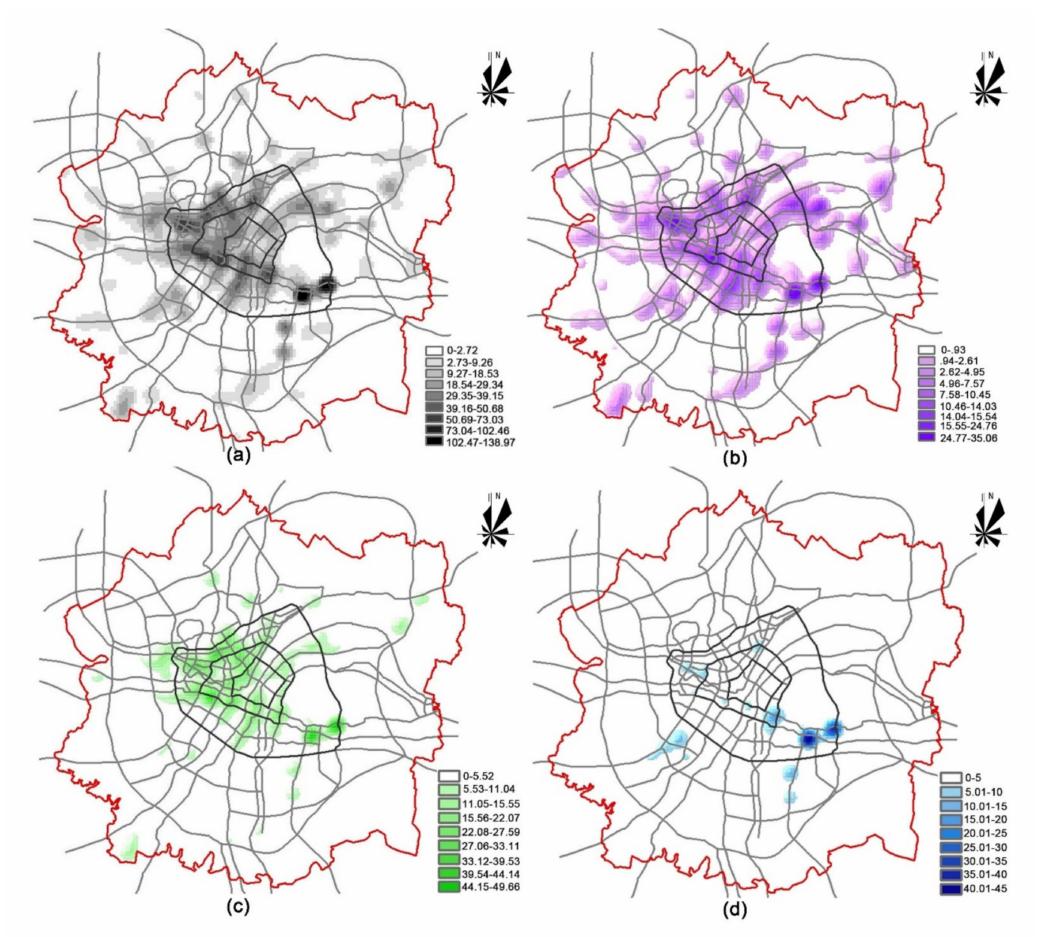
Figure 4. Spatial patterns of different manufacturing enterprises in the Wuhan metropolitan: ( a ) all manufacturing enterprises; ( b ) capital-intensive enterprises; ( c ) labor-intensive enterprises; ( d ) technology-intensive